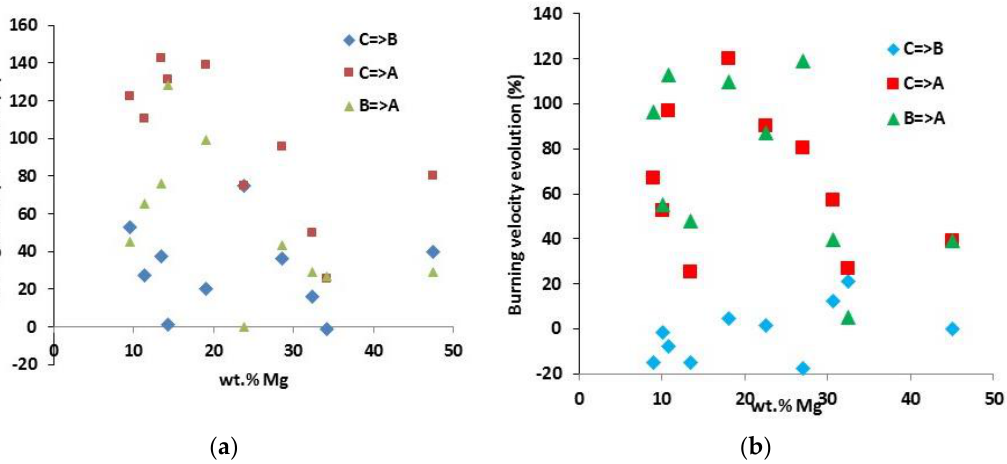
Figure 7. Quantification of burning velocity evolution of ternary compositions when changing Mg granulometric class: compositions containing 5 wt.% of DNAN ( a ) and compositions containing 10 wt.% of DNAN ( b ).